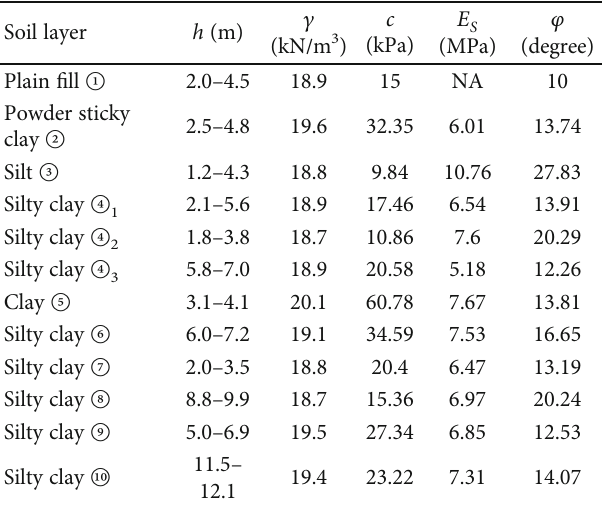
Figure 6: Schematic of the relative position of the excavation and the tunnel for the HBOB Project: (a) plan view and (b) cross-section view. Table 3: Soil parameters for the HBOB Project [53].